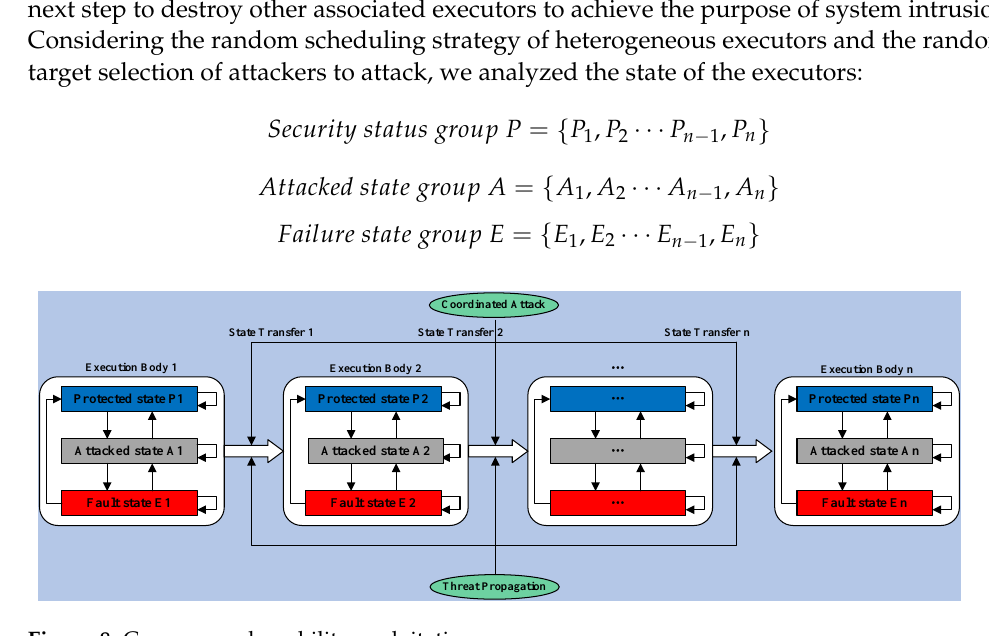
Figure 7. Common vulnerability statistics.